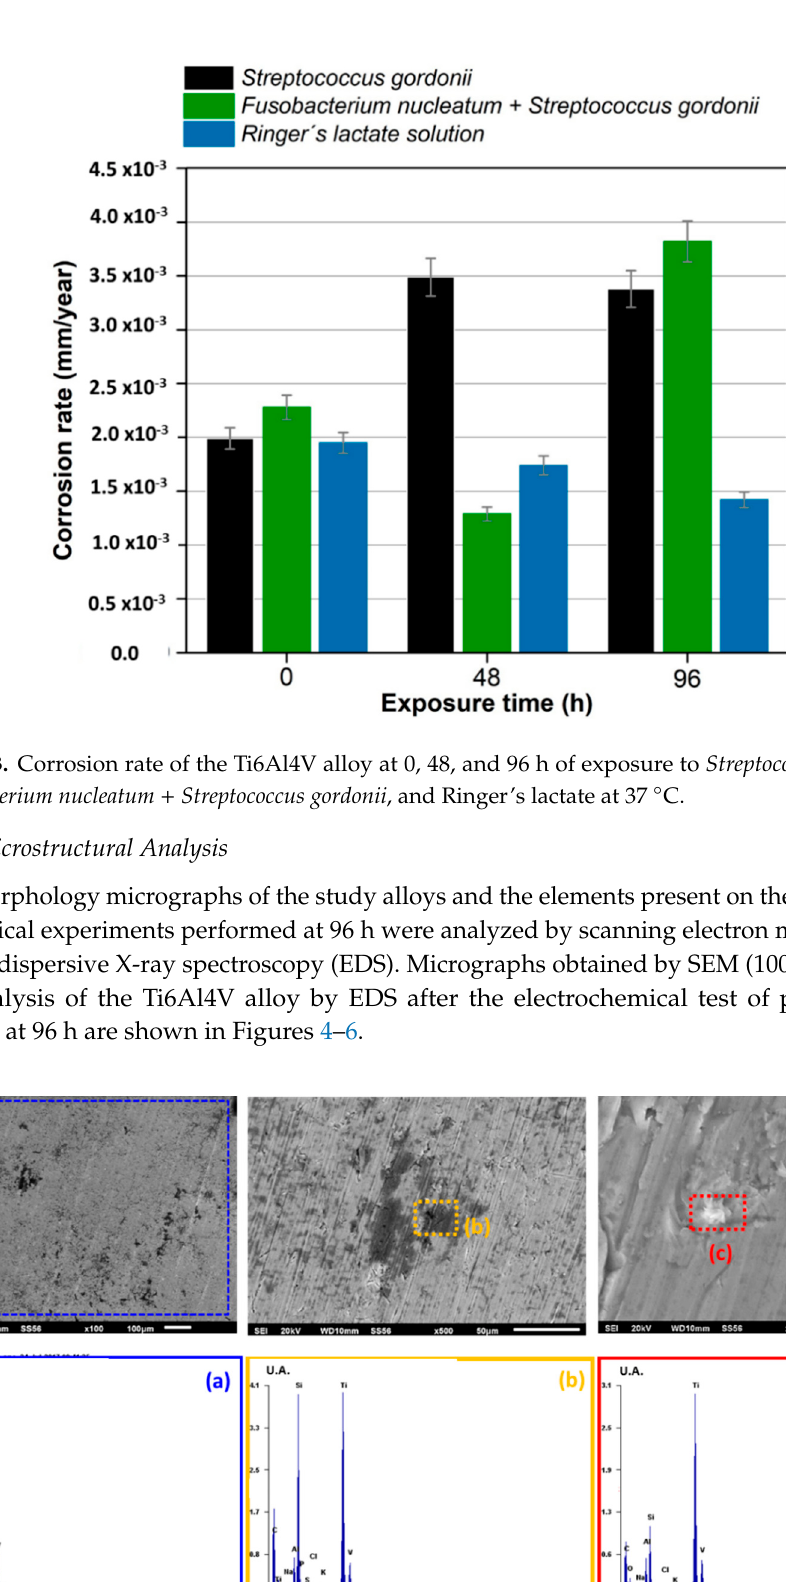
Figure 5. SEM surface morphology micrographs and EDS spectrum of Ti6Al4V in Fusobacterium nucleatum + Streptococcus gordonii: ( a ) 100X, ( b ) 500X, and ( c ) 2000X. Micrograph and EDS analysis of the Ti6Al4V alloy in Ringer´s lactate is shown in Figure 6. The metal surface does not present deposits of species with an organic nature, in contrast to solutions that contain bacteria. The elements present are characteristic of the metal base and Ringer´s lactate. The 100× micrograph shows some areas with pitting corrosion.